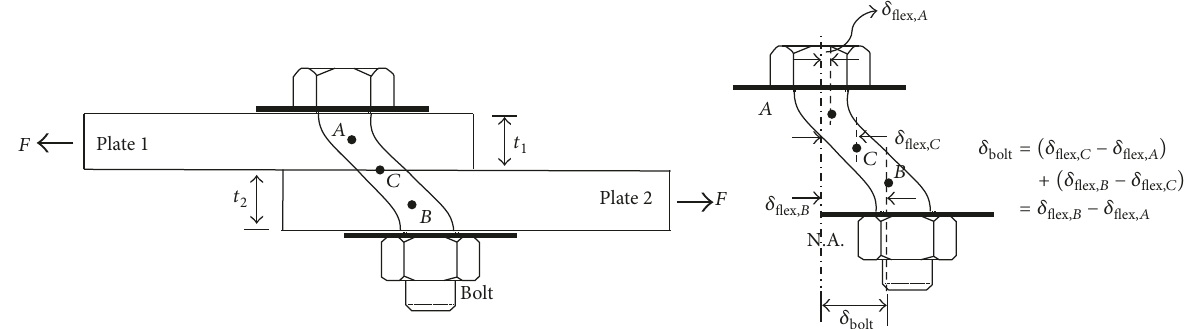
Figure 14: Flexural deformation of the